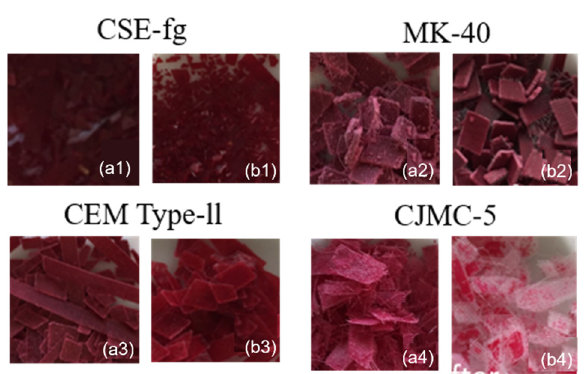
Figure 12. Photos of the grinded membranes ( a ) before and ( b ) after treatment in 25% acetoni- trile/25% methanol/25% isopropanol/25% water at pH 6. acetonitrile/25% methanol/25% isopropanol/25% water at pH